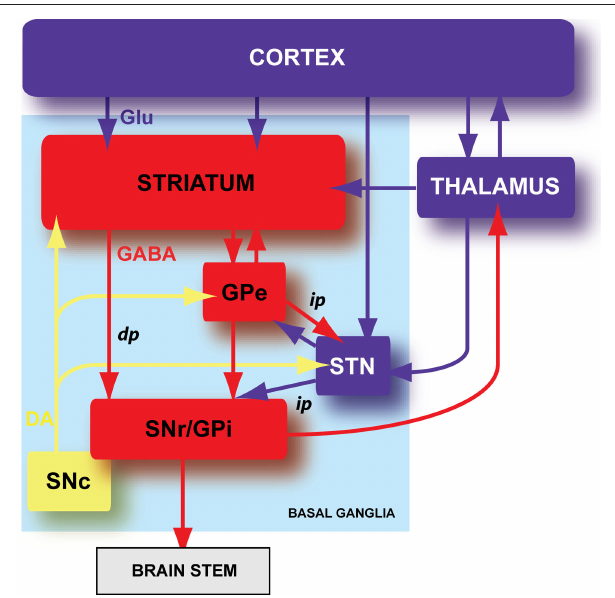
FiGure 1 | Schematic organization of the basal ganglia. Basal ganglia are an ensemble of tightly interconnected sub-cortical nuclei. In blue are represented the glutamatergic (Glu) structures, in red the GABAergic (GABA) nuclei and in yellow the dopaminergic (DA) nucleus. GPe: external part of the globus pallidus; GPi: internal part of the globus pallidus; SNr: substantia nigra pars reticulata; SNc: substantia nigra pars compacta; dp: direct pathway; ip: indirect